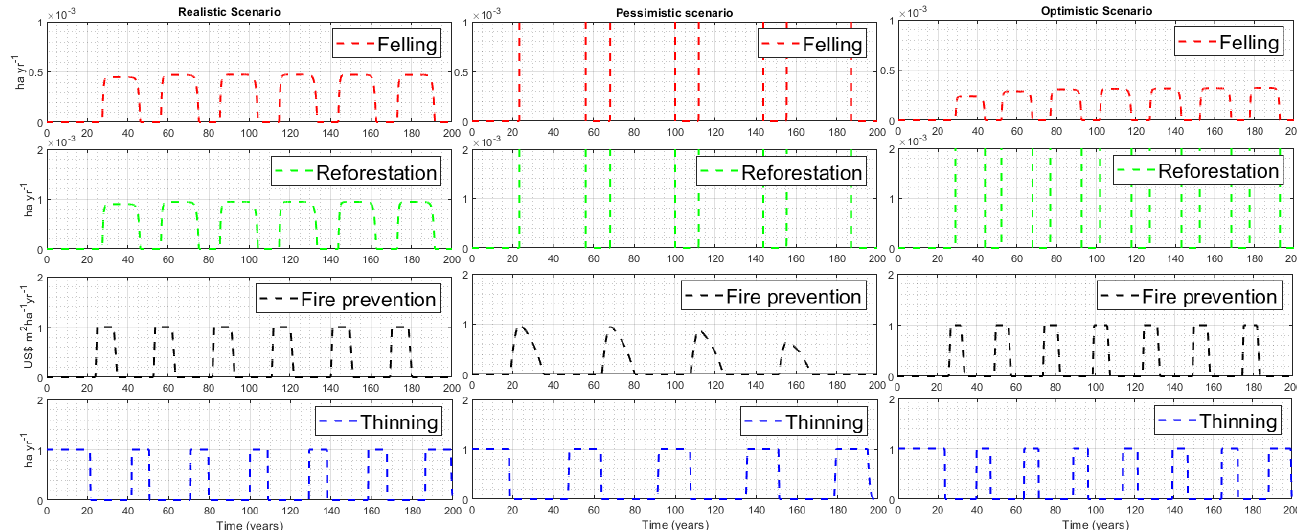
Figure 4. Optimal trajectories for the control variables in the three scenarios. The first column represents the realistic scenario, the second column the pessimistic scenario, and the third column the optimistic scenario.